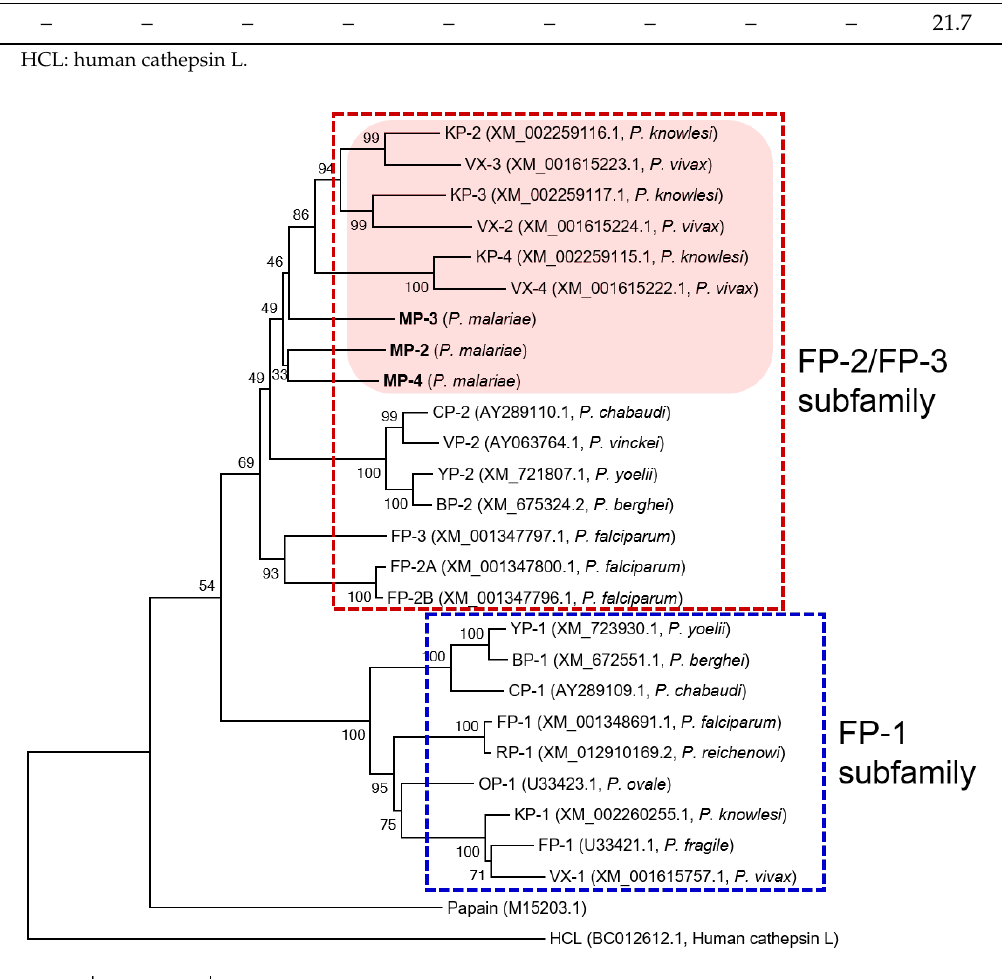
Figure 2. Phylogenetic analysis. The phylogenetic tree was constructed based on the sequences of the mature domain of each enzyme by MEGA6 using neighbor-joining algorithm with 1000 bootstrap replications. FP-family enzymes were clustered into two distinct clades: FP-2/FP-3 subfamily and FP-1 subfamily. MPs showed a closer lineage with VXs and KPs distinct from FPs. Table 1. Sequence identity between different cysteine proteases.